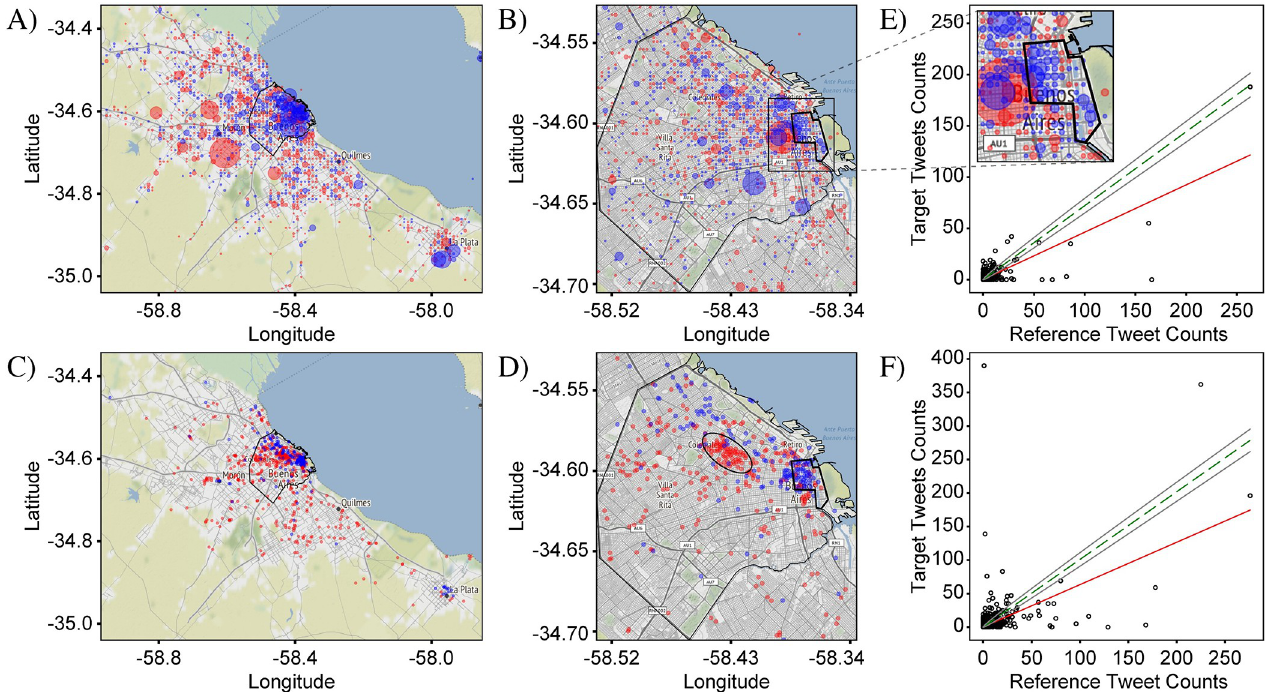
Fig 8. Analysis of informal vs formal tweets. (A) Differential distribution of informal and formal tweets in CABA+. Informal tweets were identified by the presence of one or more of a list of colloquial and vulgar words, while formal tweets were identified as those containing a more formal analogue of the same words. Blue (red) circles show where formal (informal) tweets are more prominent. The distribution shows a higher concentration of formal tweets in the city than in the surrounding areas, while informal tweets are more prominent outside the city. (B) The same as (A), except recalculated for the CABA extent. The distinction between formal and informal is a bit less clear than for the CABA+ extent, but nevertheless, there is a greater prominence of formal tweets in the North-East of the city near the coast, and especially in the Central Business District of Buenos Aires (outlined in black; see also inset of (E)). (C) Plot over the extent of CABA+ of locations with a formal character, including banks, government buildings, ministries, consulates, embassies, courts and law offices, marked by blue circles and bars, representing informal locations, marked by red circles. The distribution of formal and informal locations matches well with the distribution of formal and informal tweets in (A), with a strong concentration of formality in the North-East of the city, and more distributed informality in the rest of the city and the surrounding areas. (D) Same as (C), but zoomed in to the extent of CABA. The distribution of formal locations matches well with that of formal tweets in (B), especially in the Central Business District and along the coast The wide spread of informal locations matches that of informal tweets in (B), but the concentration in the center, marked by the black oval, which corresponds to the bar district of Buenos Aires does not. The discrepancy indicates that bars are not an exclusive context for informality, which is not surprising. (E) and (F) Frequency comparison plots for the data in (A) and (B), respectively. These blots show a moderate degree of anticorrelation, indicating the presence of a driver of variation. CABA+ Statistics: N T = 5,301, N R = 5,251, S PCC